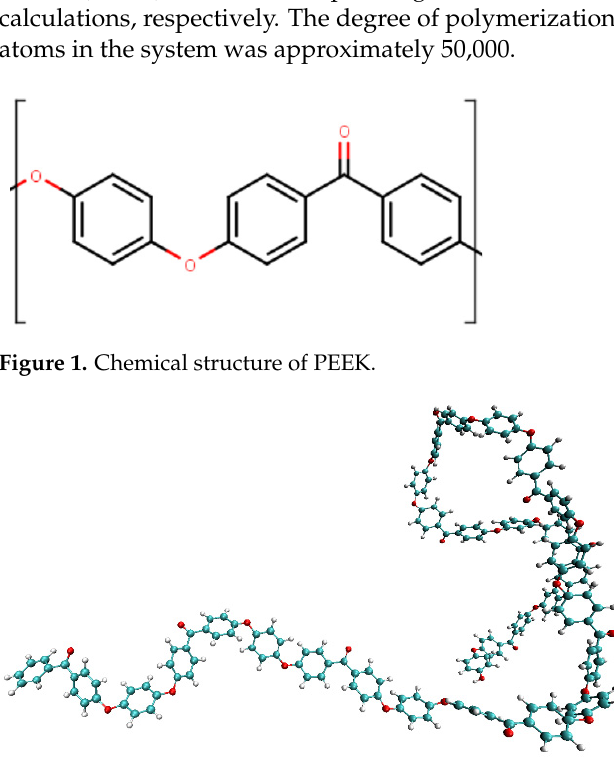
Figure 2. Snapshot of PEEK polymer ( n = 10).